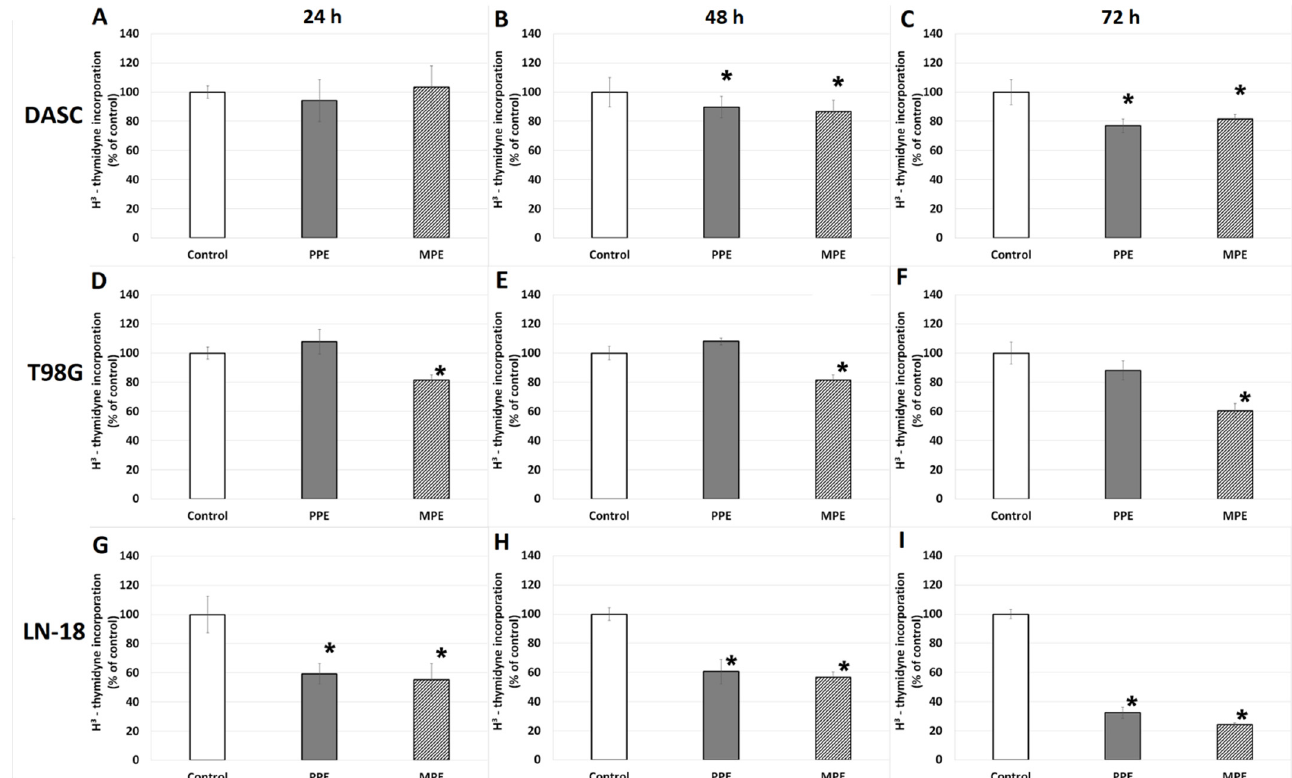
Figure 2. The [ 3 H]-thymidine incorporation into DASC, T98G and LN-18 cells after treatment with PPE and MPE. Legend: [ 3 H]-thymidine incorporation into DASC ( A – C ) and T98G ( D – F ) and LN-18 ( G – I ) cells after 24, 48, 72 h of incubation with PPE and MPE (in concentrations 30 μ g/mL). The results are presented as a percentage of control. All statistical analyses were performed using Student’s t -test (significant changes: * p < 0.05 vs. control).